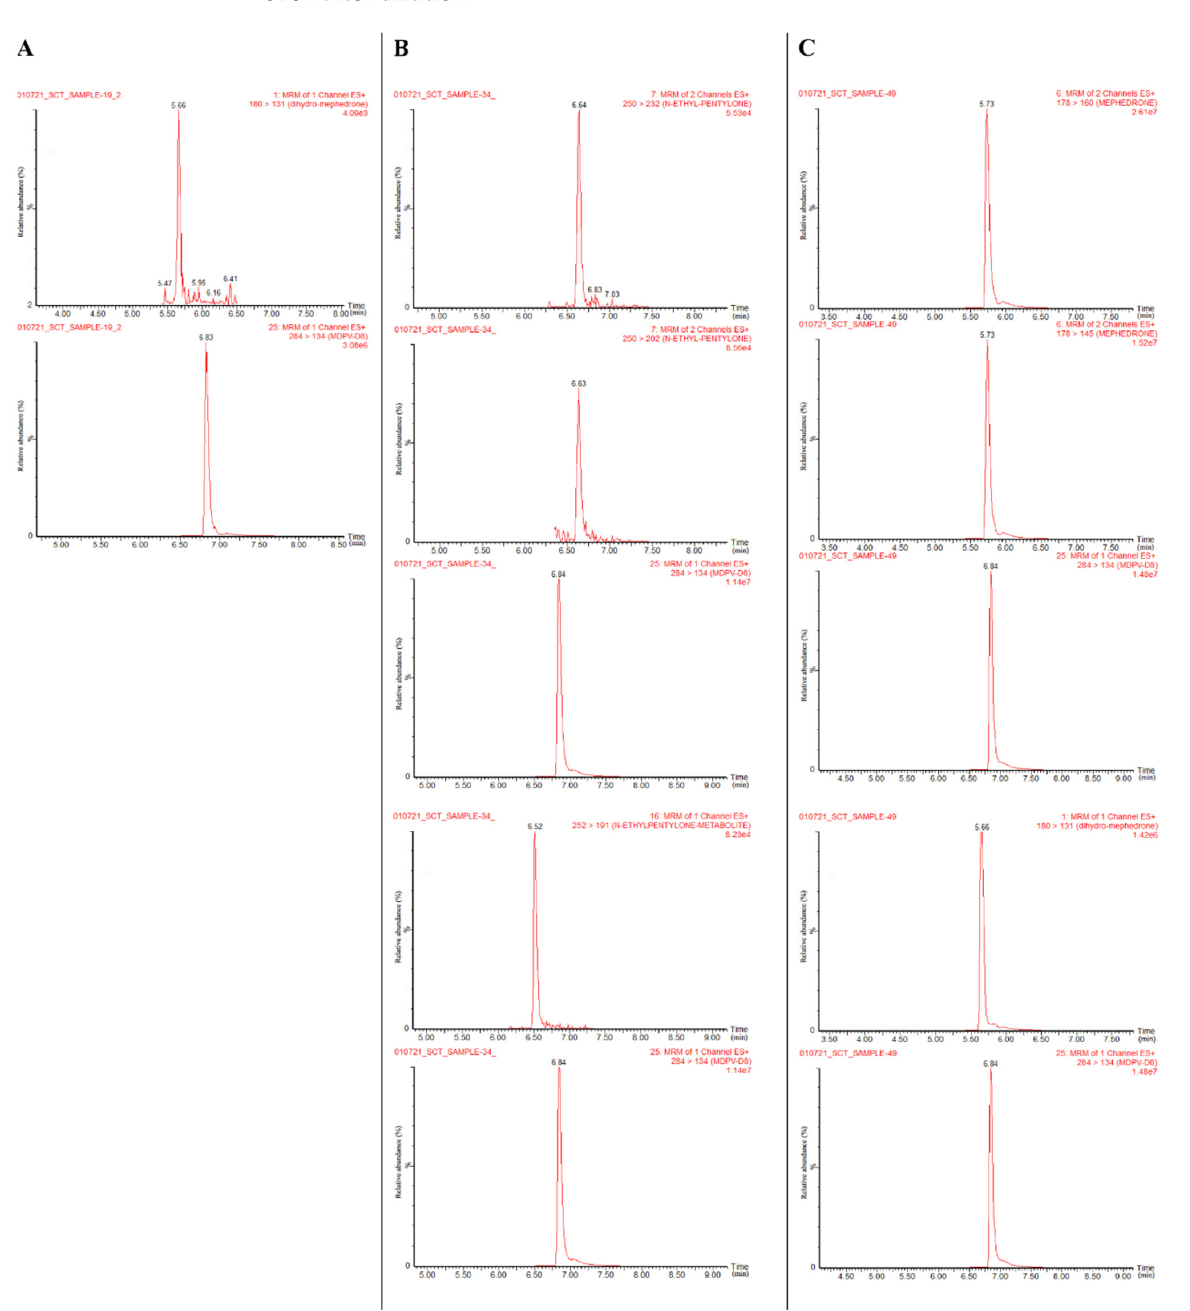
Figure 4. Results from the three authentic urine samples testing positive for target SCts: dihydro- mephedrone (sample no. 19) ( A ); N -ethylpentylone and dihydro- N -ethylpentylone (sample no. 34) ( B ); and mephedrone and dihydro-mephedrone (sample no. 49) ( C ).